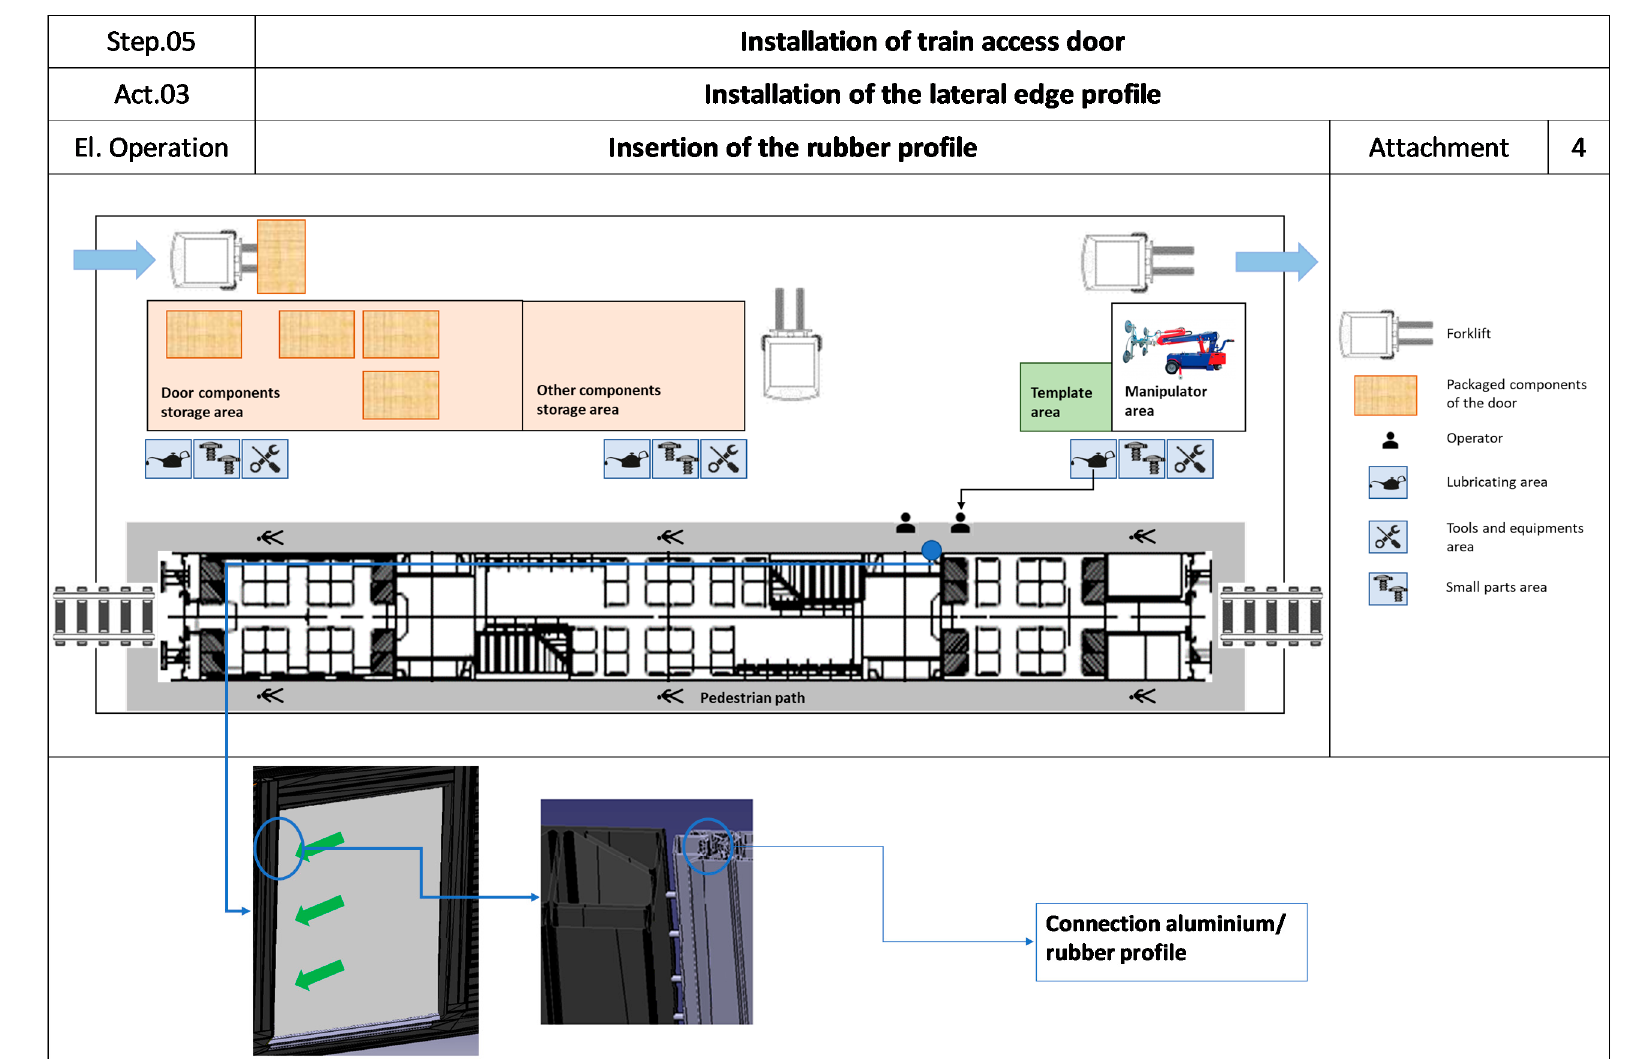
Figure 7. Example of attachment of D-JES module related to the installation of the lateral edge profile.